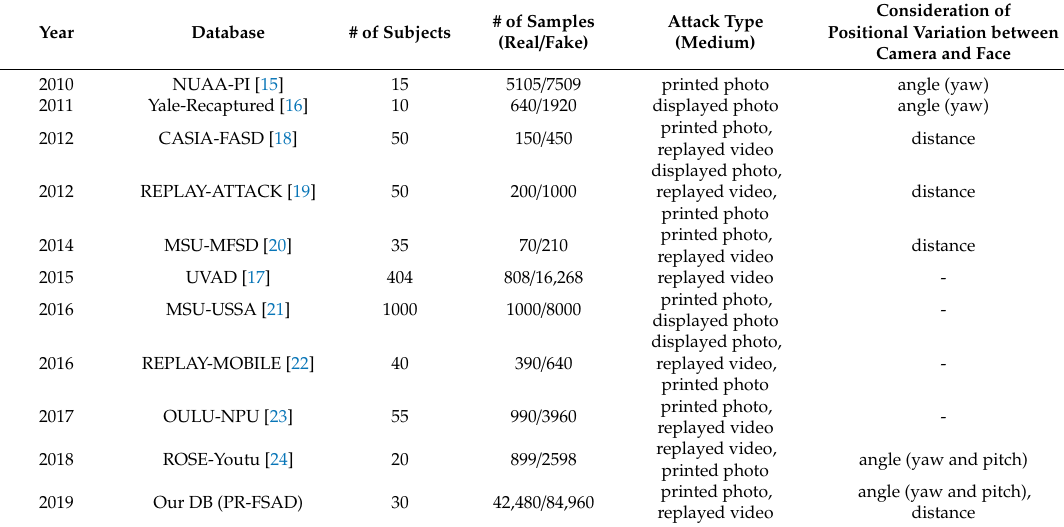
Table 1. Comparison of previous face spoofing databases (DBs) and our DB (PR-FSAD).